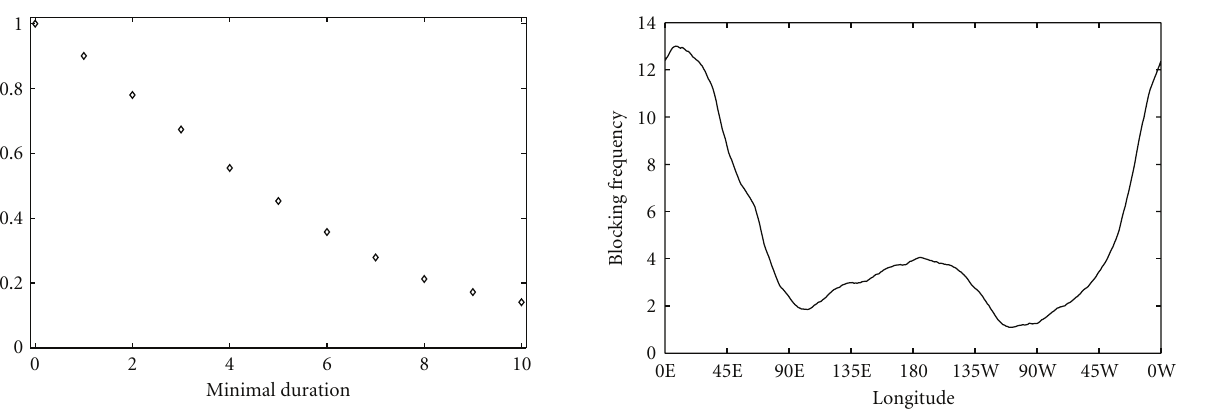
Figure 10: Northern Hemisphere blocking frequency for quantile ( Q = 0 . 7, minimum width 21 . 375 ◦ , and 3 days